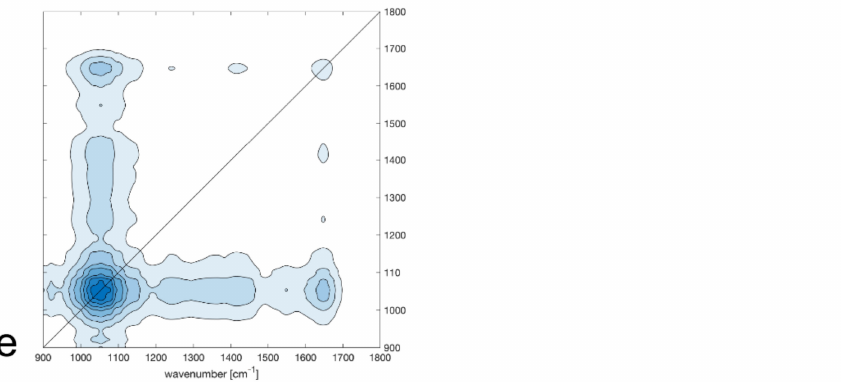
Figure 5. Synchronous maps for bee pollen samples collected on different dates: ( a ) 12 August 2018 (P1); ( b ) 2 June 2019 (P2); ( c ) 14 June 2019 (P3); ( d ) 29 June 2019 (P4), and ( e ) 20 July 2019 (P5).